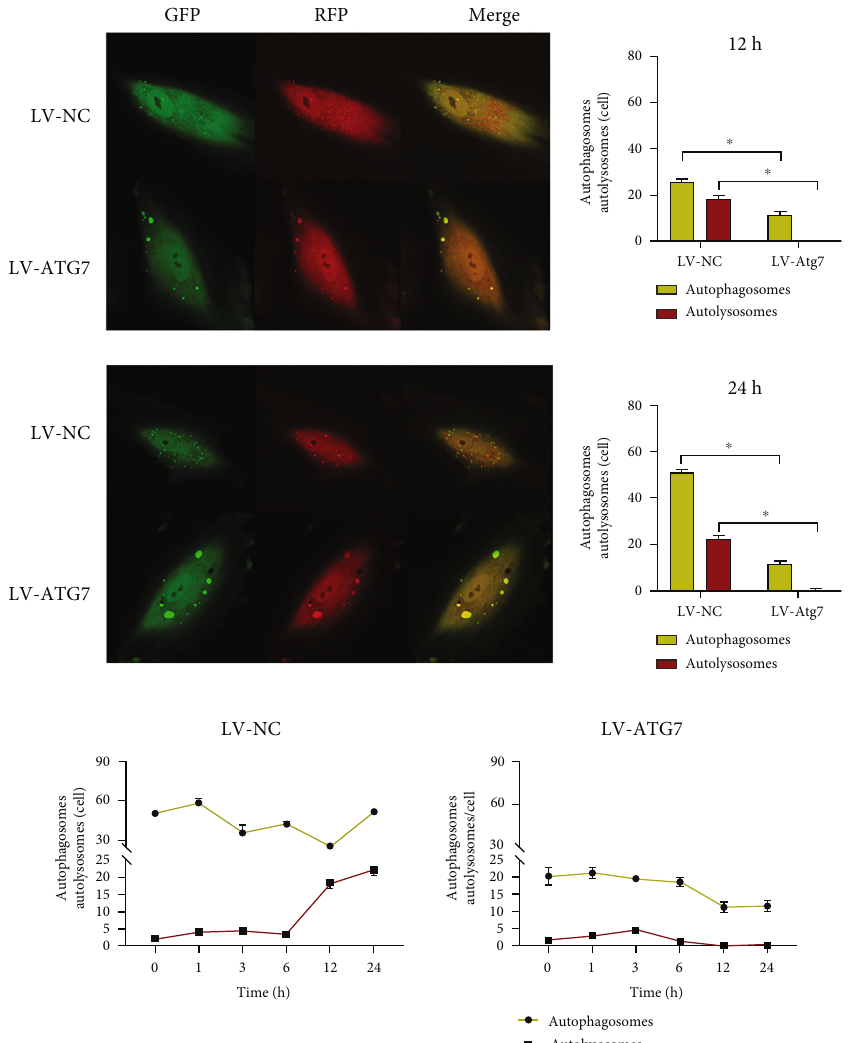
Figure 7: The detection of autophagy fl ux after knocking down the autophagy-related gene ATG7. GFP: green fl uorescent protein; RFP: red fl uorescent